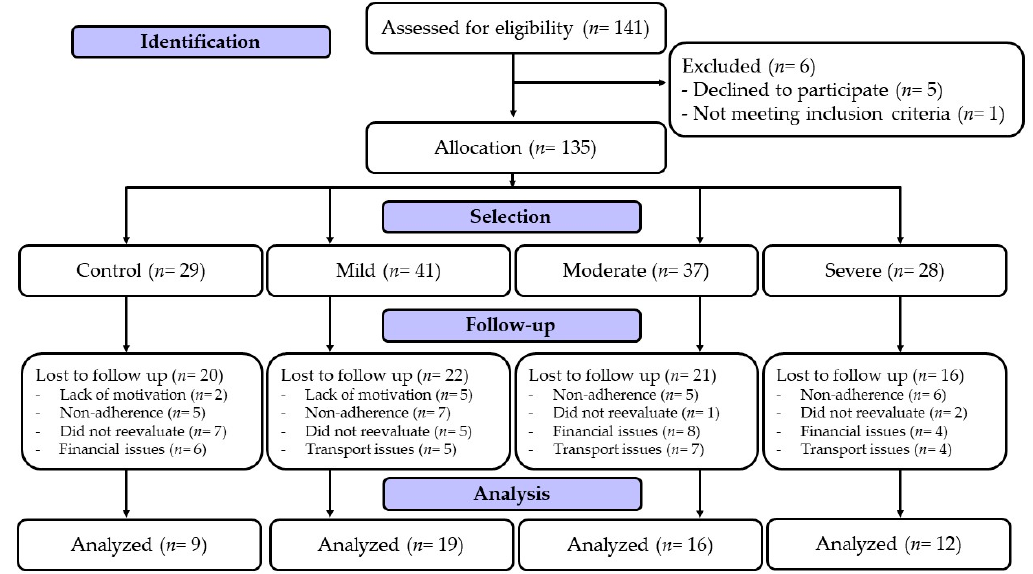
Figure 1. Study flowchart according to CONSORT.